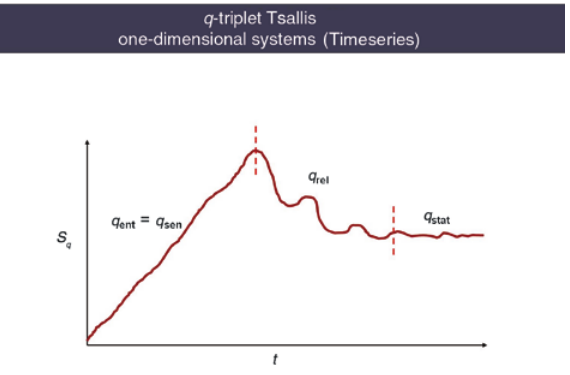
Figure 3: As the dynamics of the system evolves aiming to the q -entropy maximization it produce q -entropy. We can distinguish three different time periods. The first period corresponds to the entropy production through the q parameter of the Tsallis sen q -triplet. The second period corresponds to some kind of relaxation process through the q parameter of Tsallis q -triplet. Finally, as the rel system lives at the stationary state with maximaized q -entropy it reveals fluctuations through the q parameter of Tsallis q stat